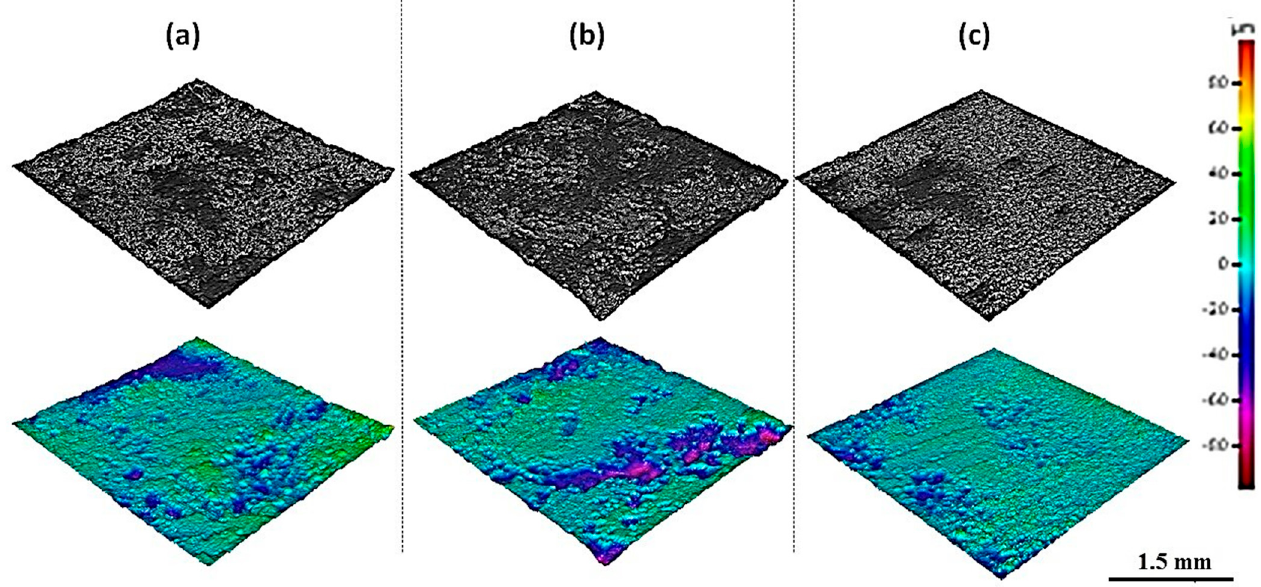
Figure 5. Three − dimensional SEM image of Al alloy electrode surfaces from the last cycles visualizing corrosion morphology: ( a ) 99.99% Al, ( b ) 99.5% Al 0.5% Fe, ( c ) 99% Al 1% Fe (scale for color contrast is in µm).